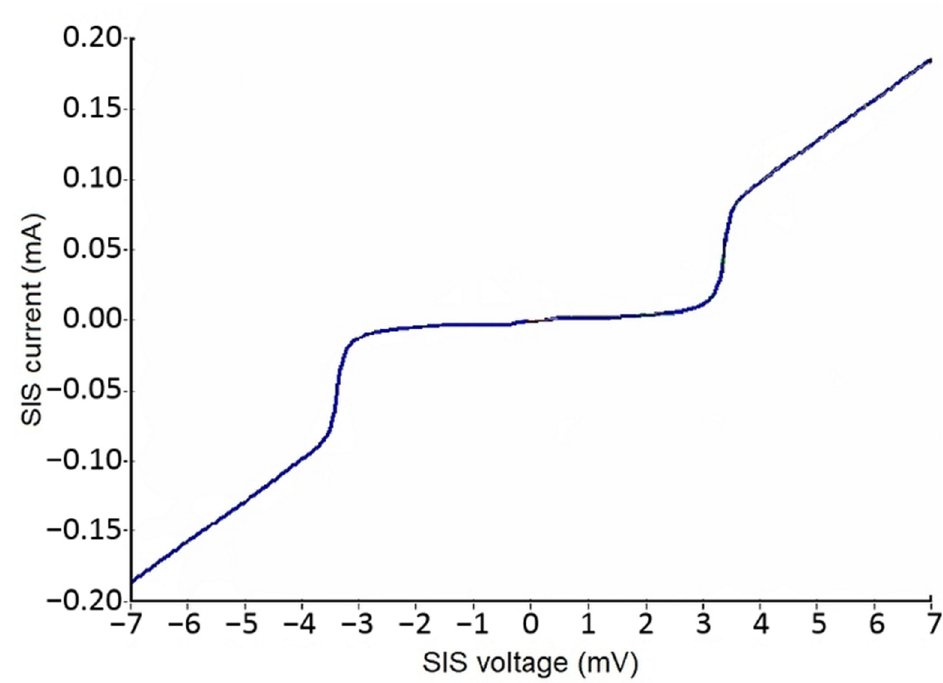
Figure 9. I–V characteristics of the Nb–AlN–NbN junction with an area of 0.15 µm 2 with a current density of 47 kA/cm 2 , R n = 34.53 Ω , R j / R n = 21.1, V g = 3.36 mV fabricated using EBL and plasma chemical etching in a CF 4 atmosphere. −0.6−0.4−0.20.00.20.40.6